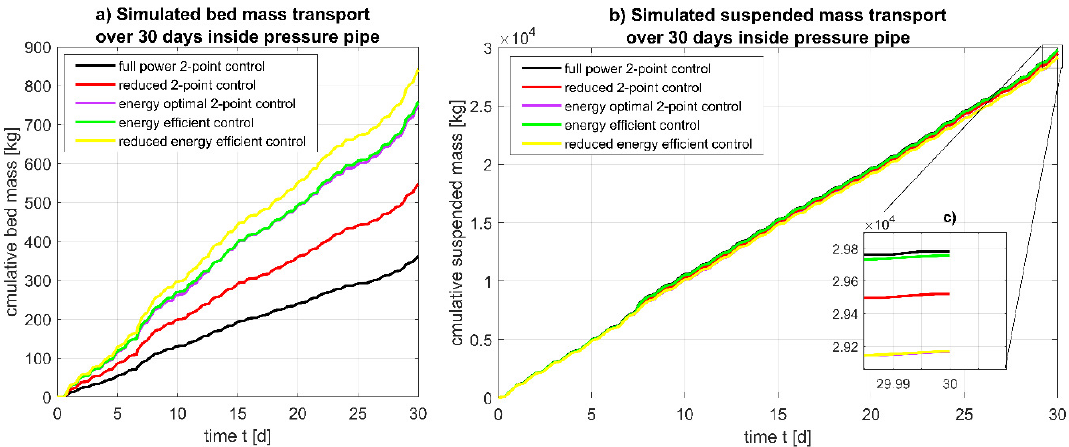
Figure 6. Sediment transport simulation for five di ff erent pumping modes over 30 days. Cumulative